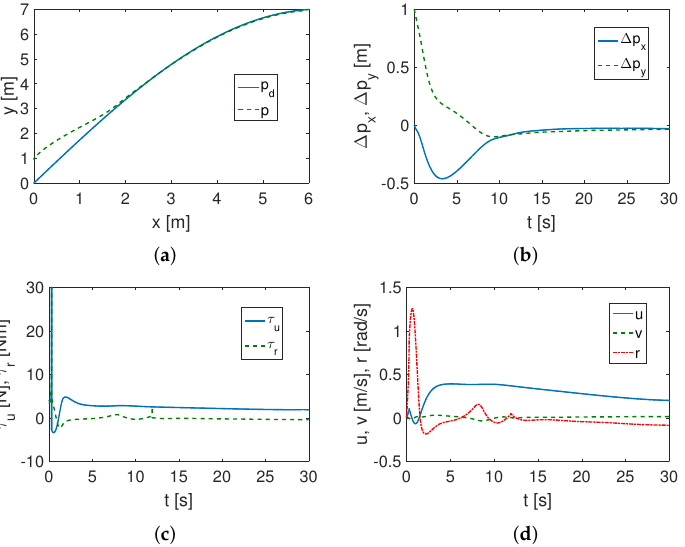
Figure 6. Simulation results for TSMC and sine trajectory (with friction): ( a ) desired ( p d ) and realized ( p ) trajectory; ( b ) position errors ∆ p x , ∆ p y (in inertial frame); ( c ) input signals components (applied force and torque) τ u , τ r ; ( d ) actual velocities u , v , r